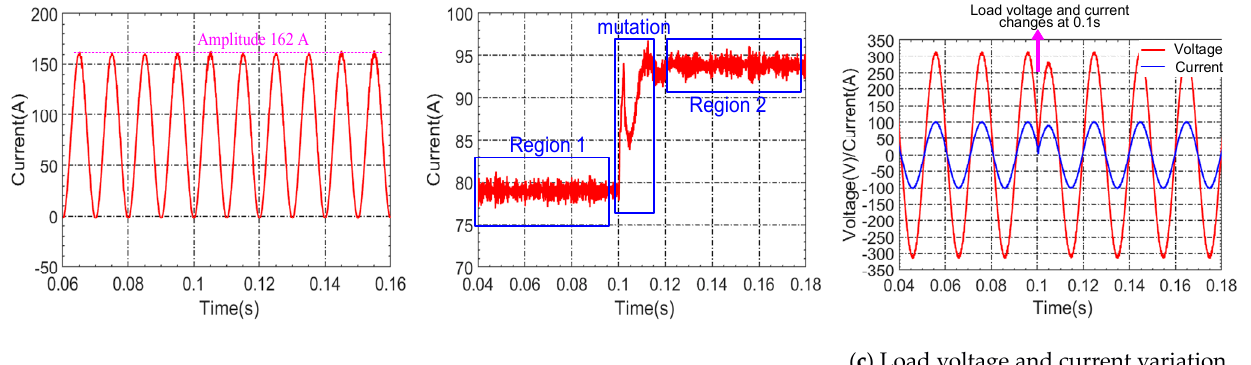
Figure 5. DC − bus current fluctuation comparison in single-phase charging mode.